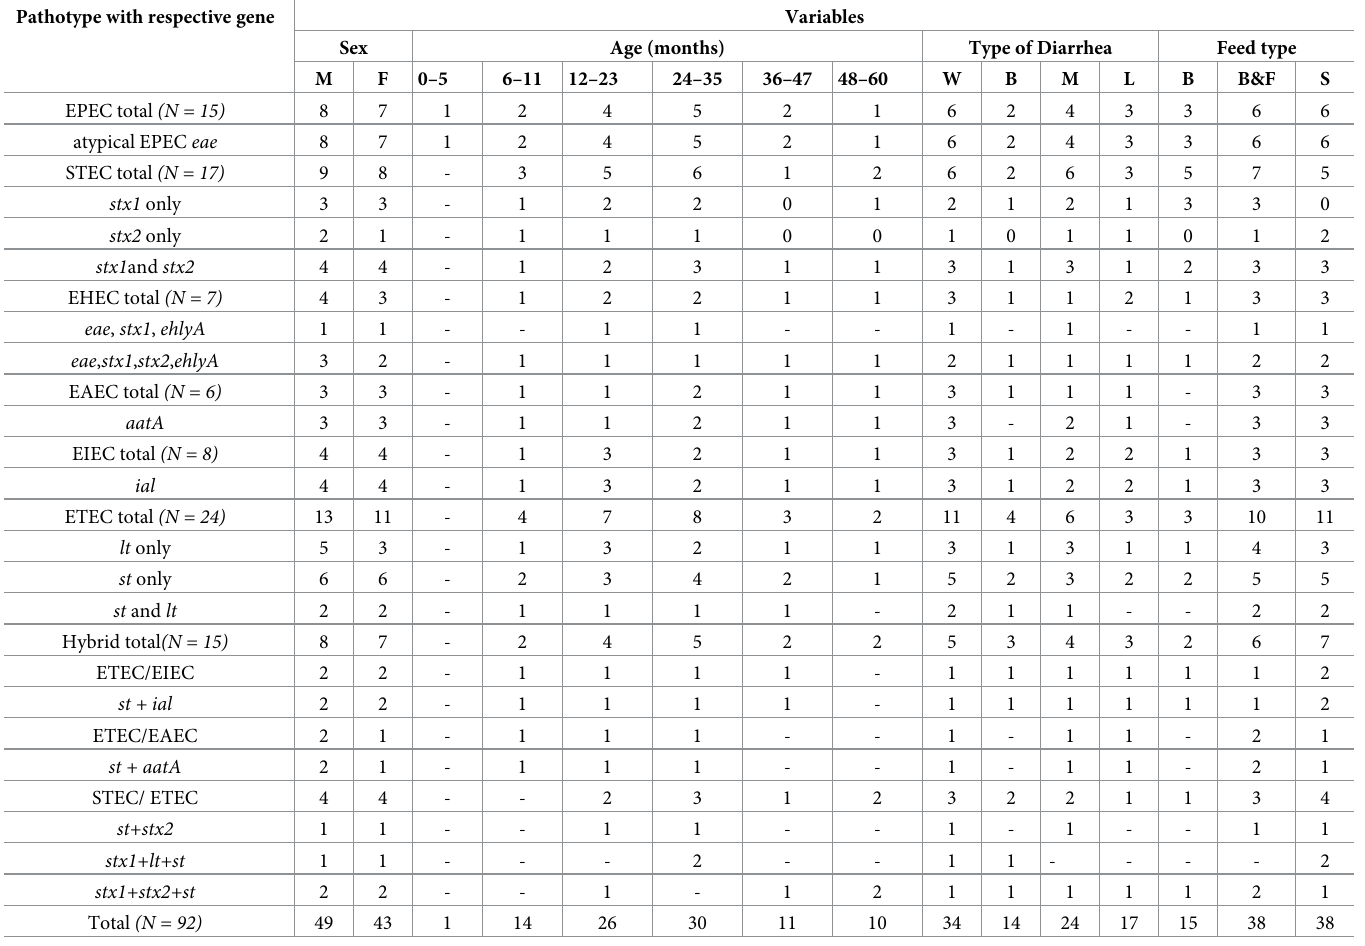
Table 4. Distribution of DEC pathotypes with clinical features and risk factors in diarrheic